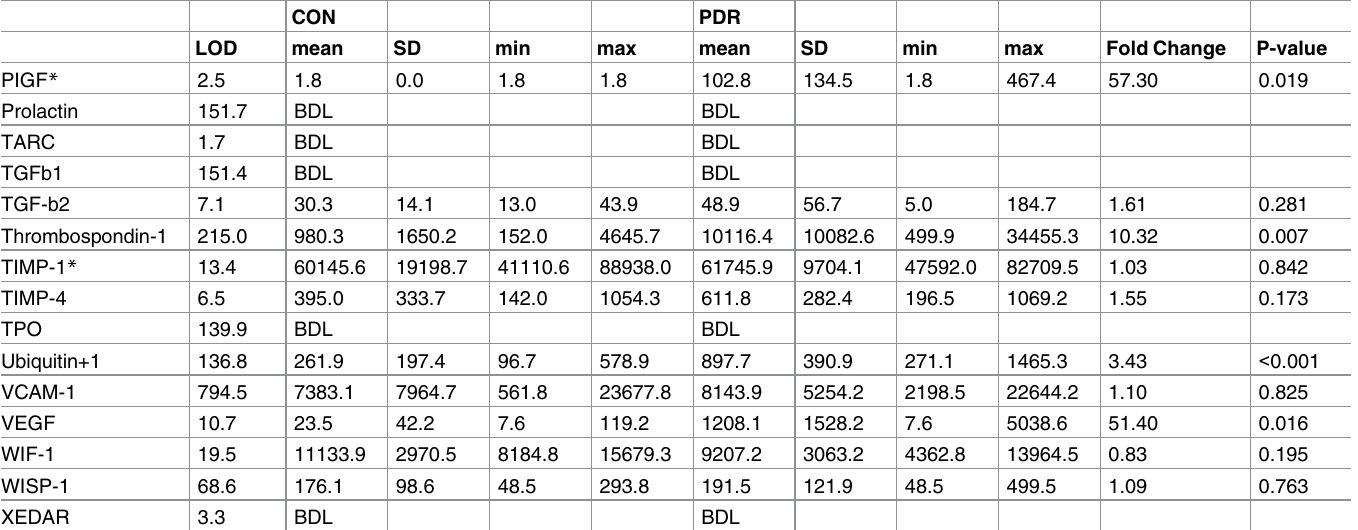
fold changes between PDR patients and controls were comparable with those of the first study group and the differences were statistically significant, except for NRG1 β 1 (S3 Table). with and without FVMs. Vitreous samples were divided into control, PDR patients without